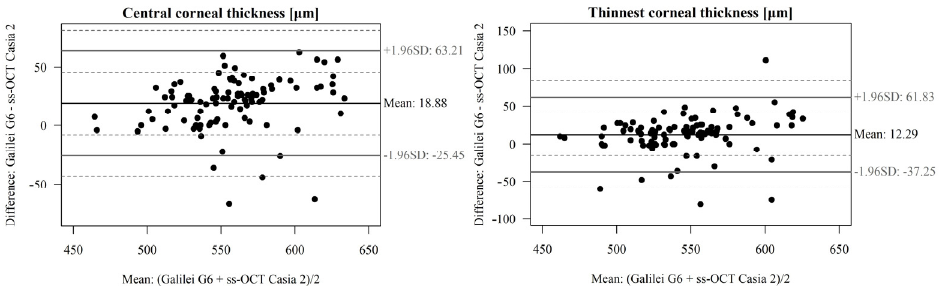
Figure 4. A Bland–Altman plot showing the agreement of central corneal thickness CCT (um) and thinnest corneal thickness TCT (um) measurements between the OCT Casia 2 and Galilei G6 Dual Scheimpflug Analyzer. The line shows the mean difference, and the top and bottom dashed lines show the upper and lower 95% LoA, respectively.